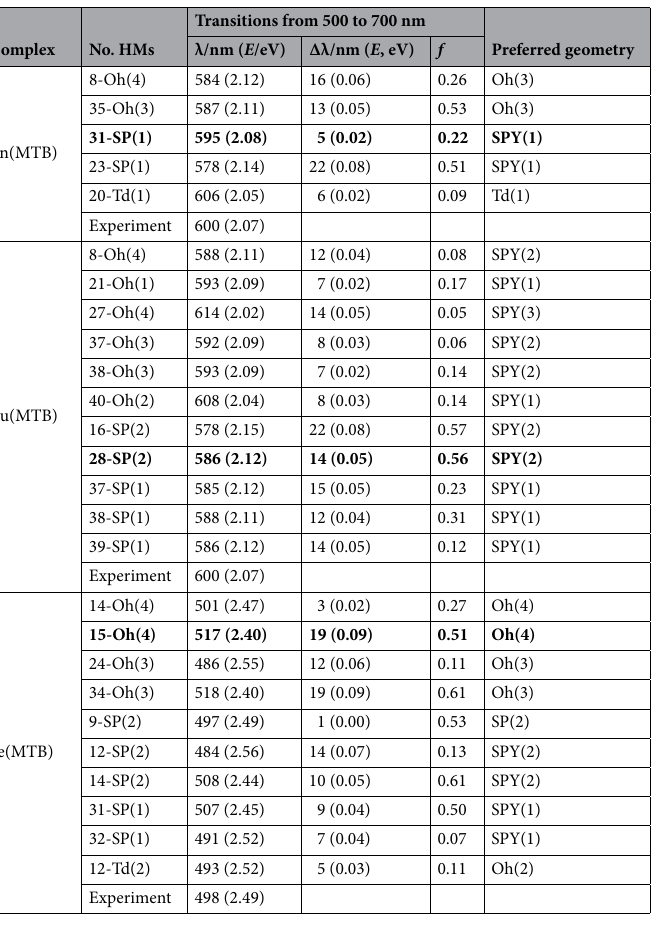
Table 4. Computed wavelengths ( λ ) and energy ( E ), difference between the theoretical and experimental values of wavelengths (Δ λ ) and oscillator strengths ( f ) of LETs for the Zn(MTB), Cu(MTB), and Fe(MTB) complexes. The significances of bold show the final optimized HMSs for the Zn(MTB), Cu(MTB), and Fe(MTB) complexes. The number in parentheses indicates the number of water molecules involved in the coordination